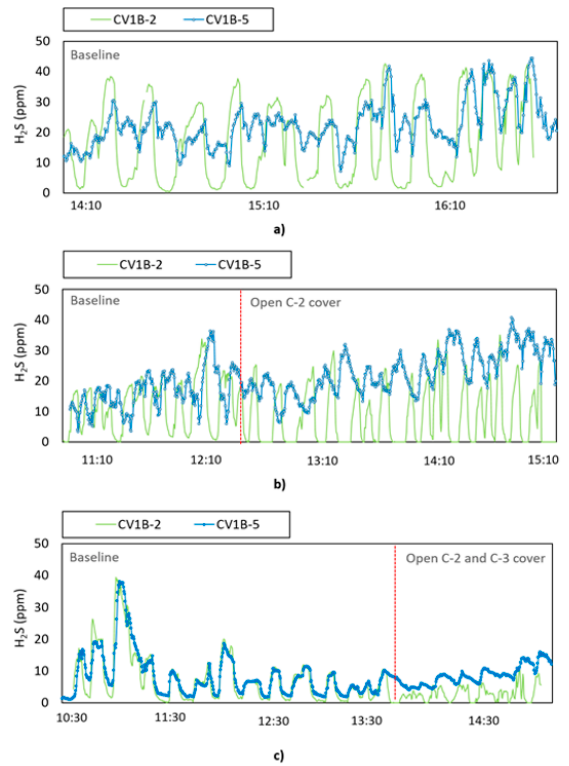
Figure 7. Concentration of H 2 S over time: ( a ) at baseline (16 May 2018), ( b ) with 1 open MH cover (17 May 2018) and ( c ) 2 open MH covers (8 June 2018).